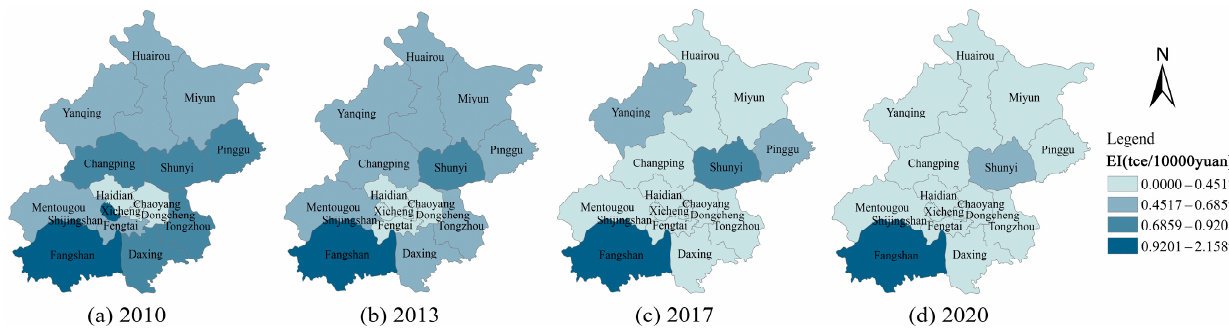
Figure 5. Development trend of energy intensity in Beijing’s municipalities from 2010 to 2020. In this study, Moran’s I index [77] is also used to test the spatial correlation of CE and EI. From Figures 4 and 5, it can be seen that CE and EI have some similarities between neighbouring regions. Therefore, the neighbouring weight matrix (w1) is used to